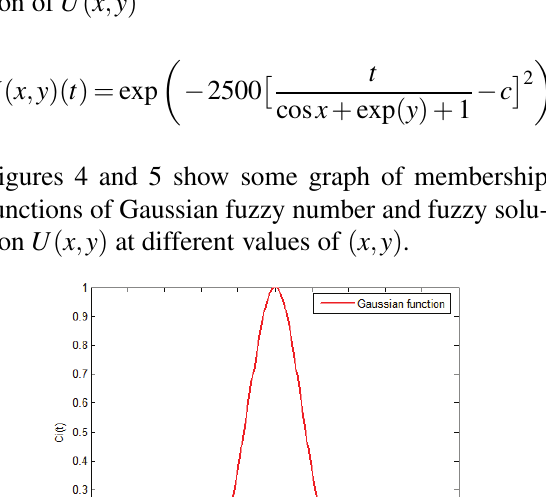
Fig. 6. The lower bounded, deterministic and upper bounded solutions of PHFDEs